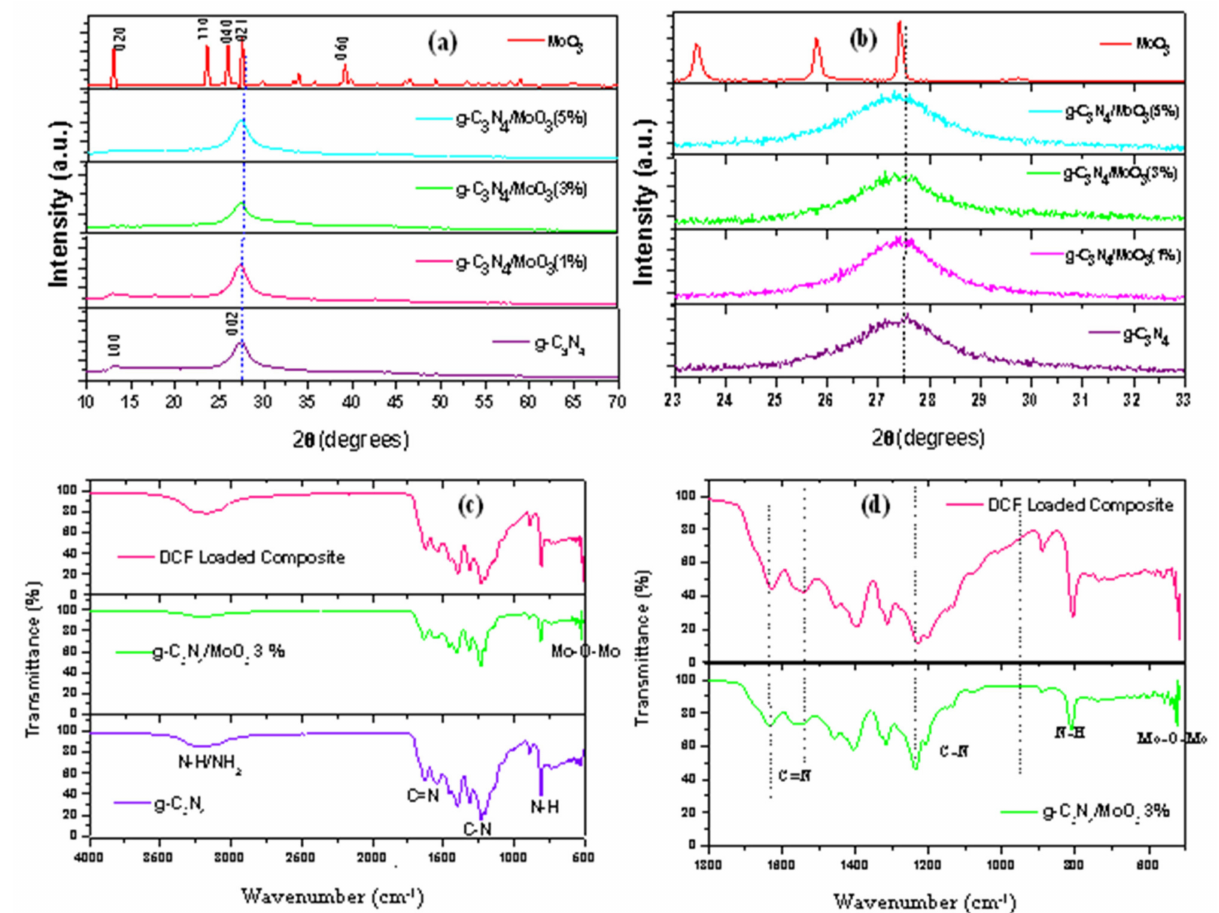
Figure 1. ( a ) XRD spectra and ( b ) resolved XRD of components and binary g-C 3 N 4 /MoO 3 nanohybrids; ( c ) FTIR Spectra and ( d ) resolved FTIR of as prepared and diclofenac loaded